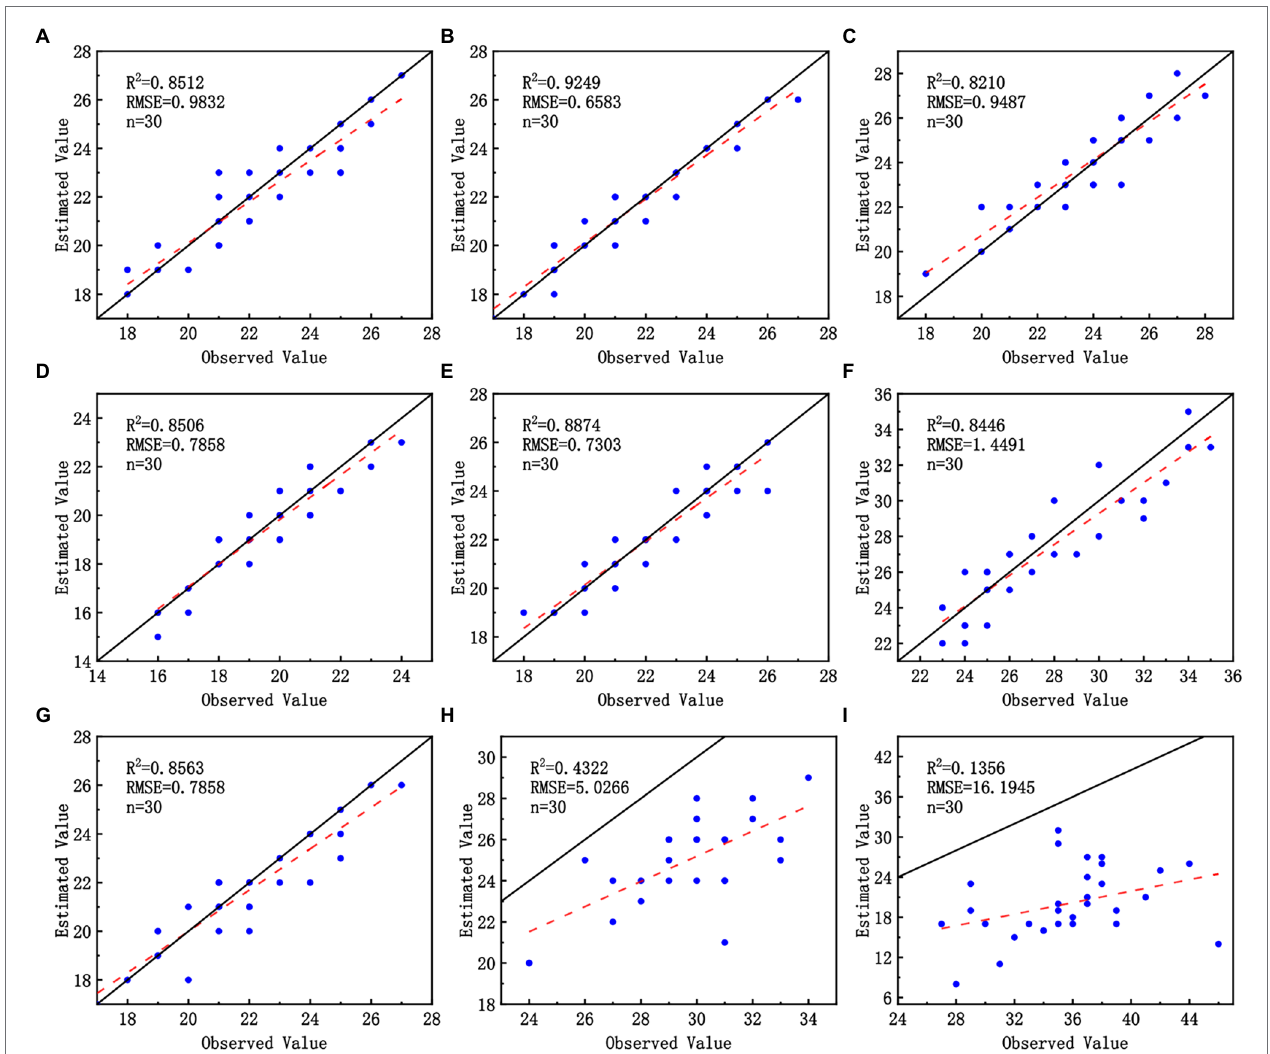
FIGURE 9 | Performance of the improved model on three wheat scenes datasets: (A–C) correspond to P1, P2, and P3; (D–F) correspond to D1, D2, and D3; (G–I) correspond to H1, H2, and